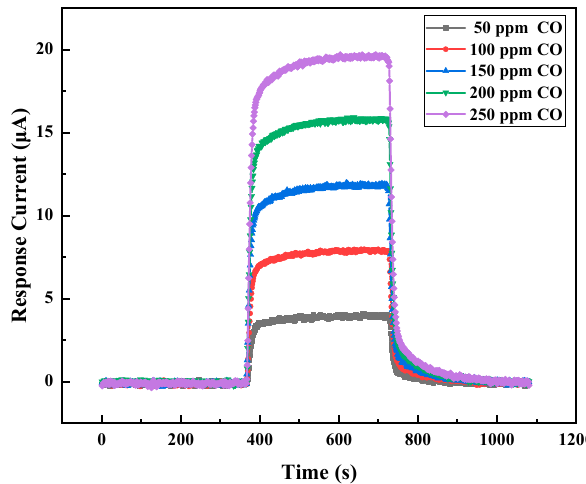
Figure 10. Transient response curves of the sensor to different concentrations of CO.